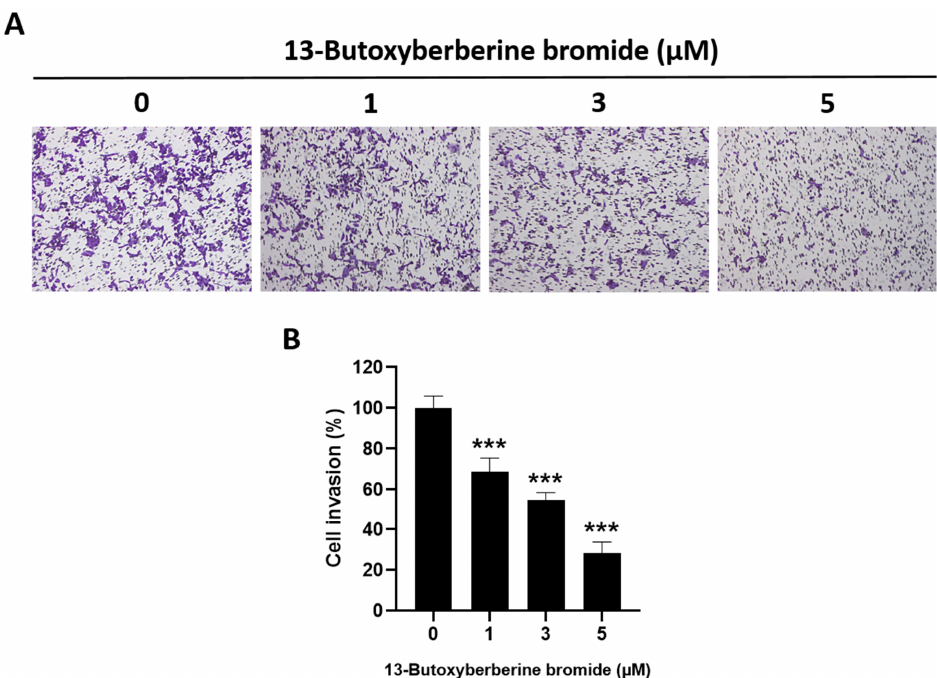
Figure 4. Inhibitory effect of 13-butoxyberberine bromide on cell invasion in A431 cells. ( A ) Mor- phology of invaded A431 cells after staining with crystal violet under an inverted microscope (100× magnification). ( B ) The histogram shows percentage of cell invasion after incubation with 13-butoxyberberine bromide. Data were expressed as mean ± SD ( n = 3). *** p < 0.001; significant difference from the control group.